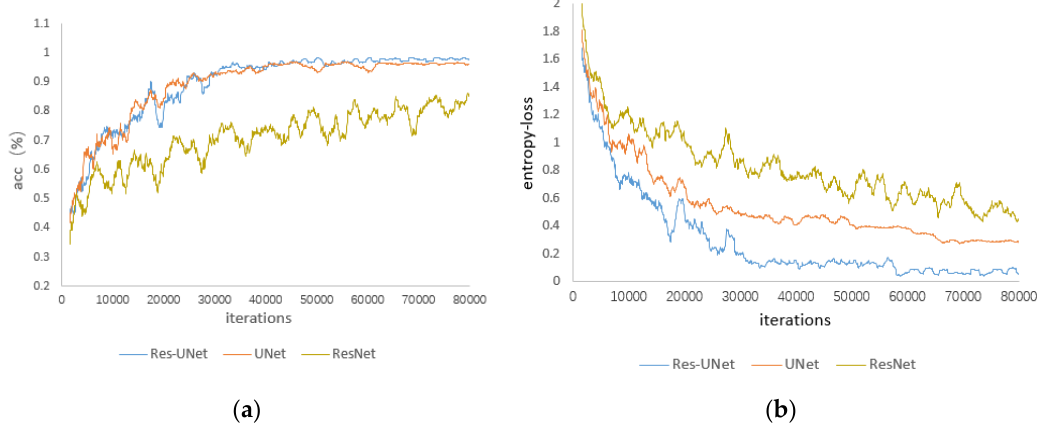
Figure 8. Training accuracy (a) and loss ( b ) curve of ResNet, UNet, and Res-UNet.